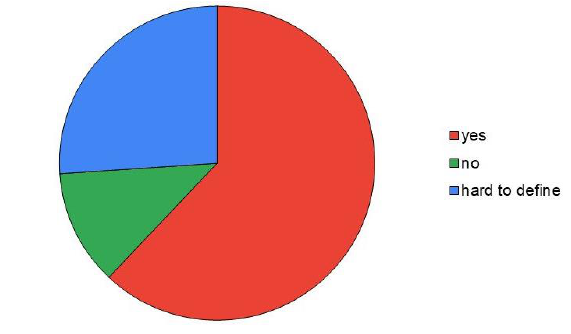
Fig. 6. The distribution of answers to the question "Is there Fig. 7. Distribution of answers to the question "Are there something in the place where you work that makes it stand symbolic places/objects in the place where you out from the others?"